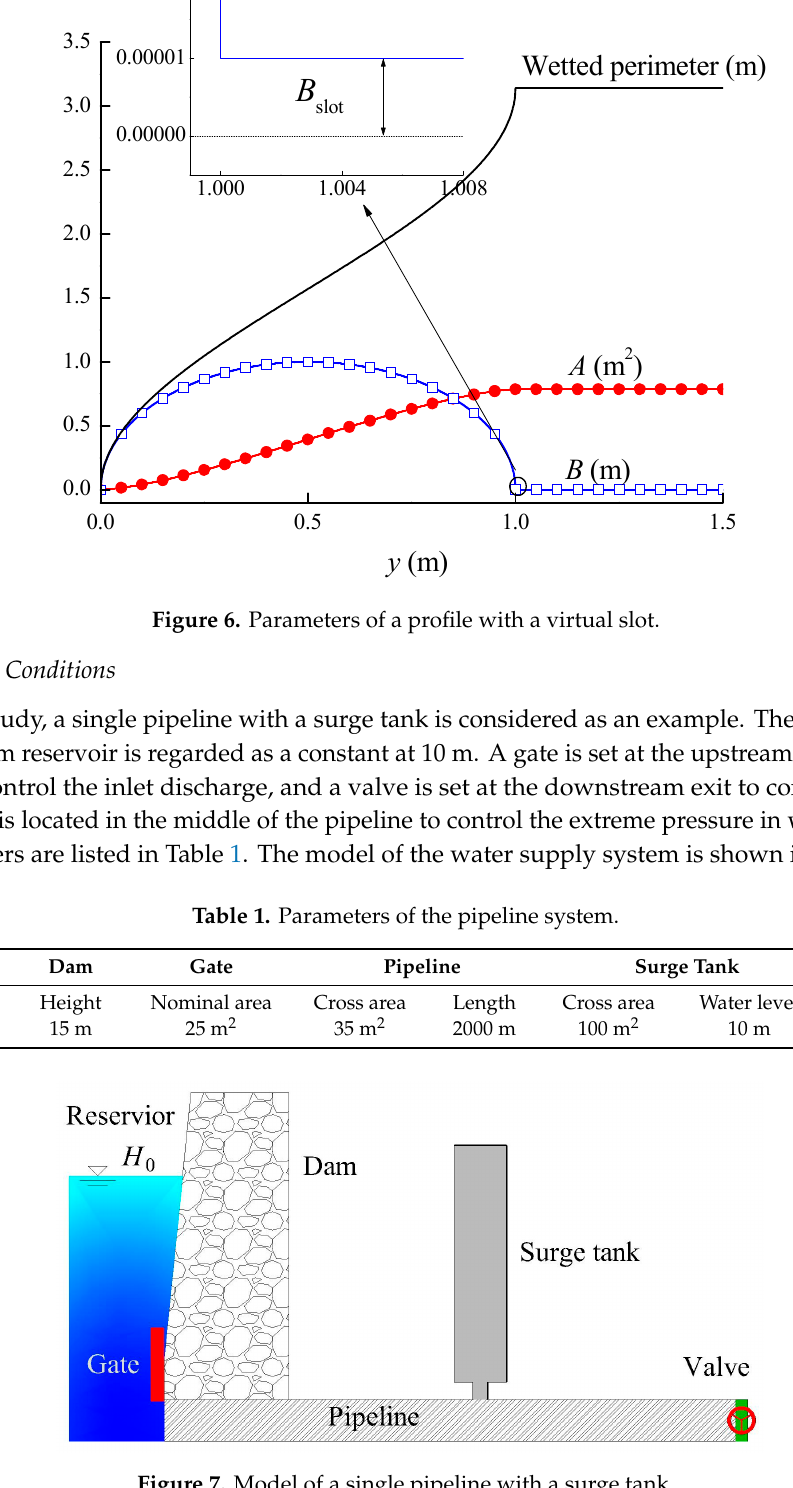
Figure 7. Model of a single pipeline with a surge tank.